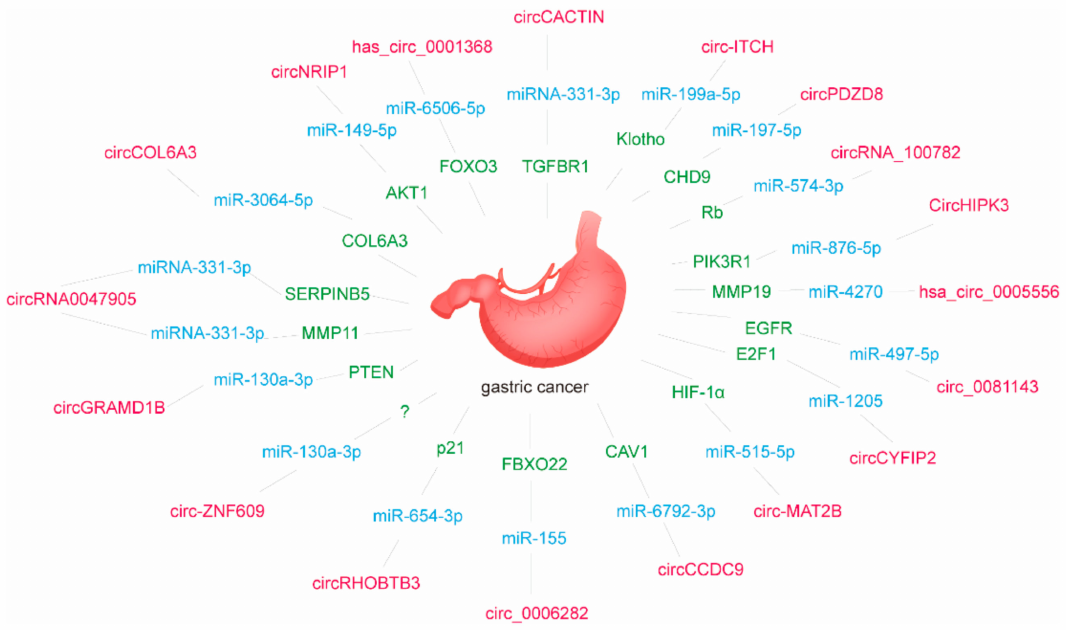
Figure 2. CircRNA-mediated ceRNETs in GC. Table 3. The mechanism of circRNAs as ceRNAs in